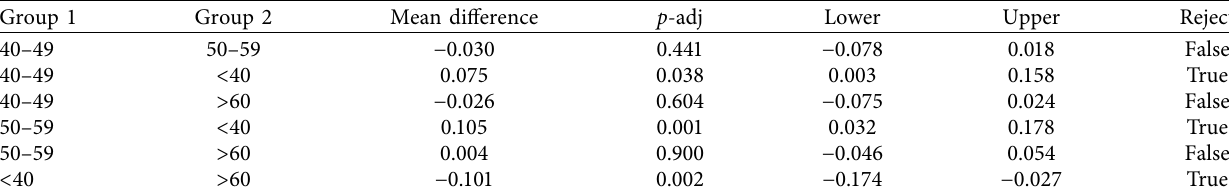
Table 5: Tukey HSD of sentiment analysis by age groups, FWER � 0.05.